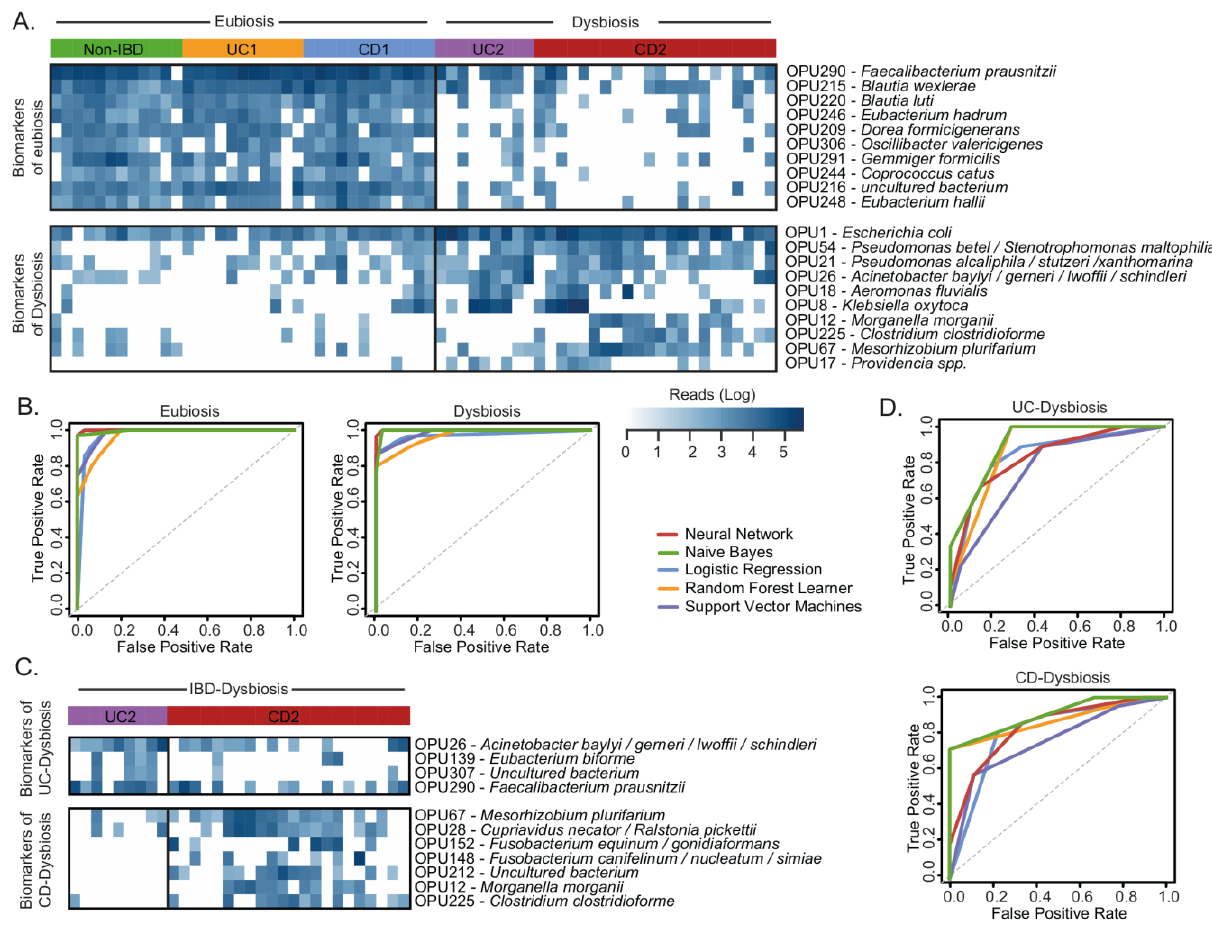
FIGURE 6: Evaluation of OPUs as biomarkers for IBD. (A) Heatmap showing the number of reads (log scale) of the best 20 indicator OPUs for dysbiosis and eubiosis in IBD. Rows represent OPUs and columns the patients ordered by groups. (B) Evaluation of five machine learning models and the above panel of twenty indicator OPUs to discriminate dysbiosis from eubiosis in the IBD patients. (C) Heatmap showing the number of reads (log scale) of the best 11 indicator OPUs for the UC (UC2) and CD (CD2) patients with dysbiosis. Rows represent OPUs and columns the patients ordered by groups. (D) Evaluation of five machine learning models and the above panel of 11 indicator OPUs to dis- criminate UC2 patients from CD2 patients. The diagnostic performance of each classifier model is represented by ROC curves and the area under the curve is indicated in Table